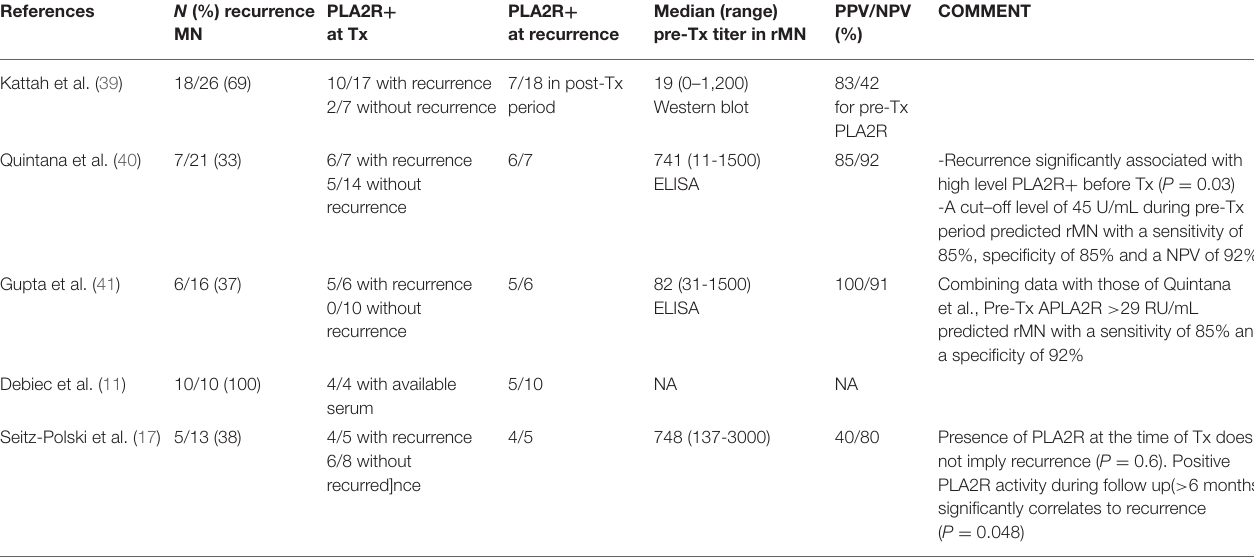
TABLE 1 | PLA2R positivity and recurrent